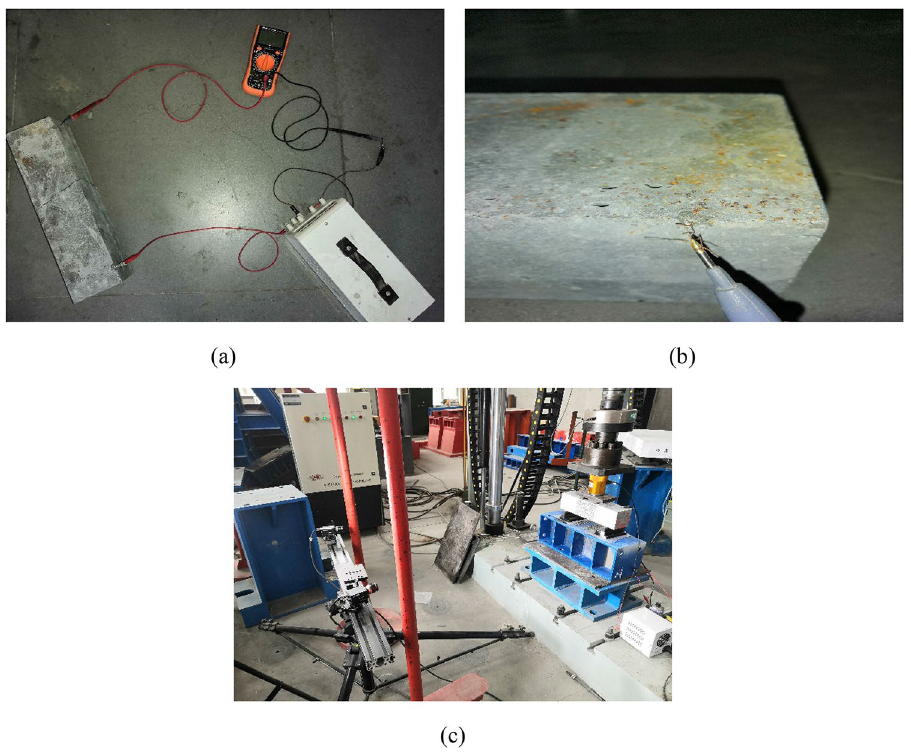
Figure 3. Test and instrument